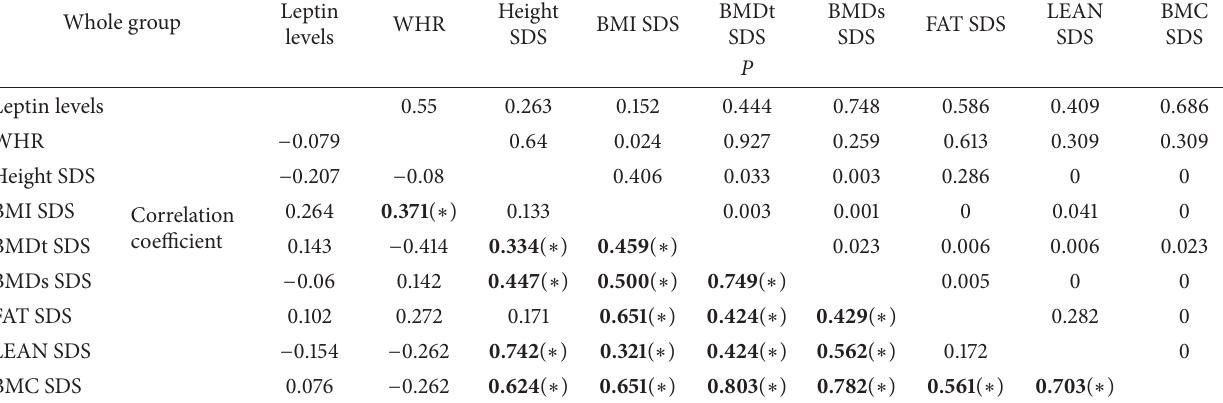
Table 5: Correlation between anthropometric and densitometric parameters in the whole group.